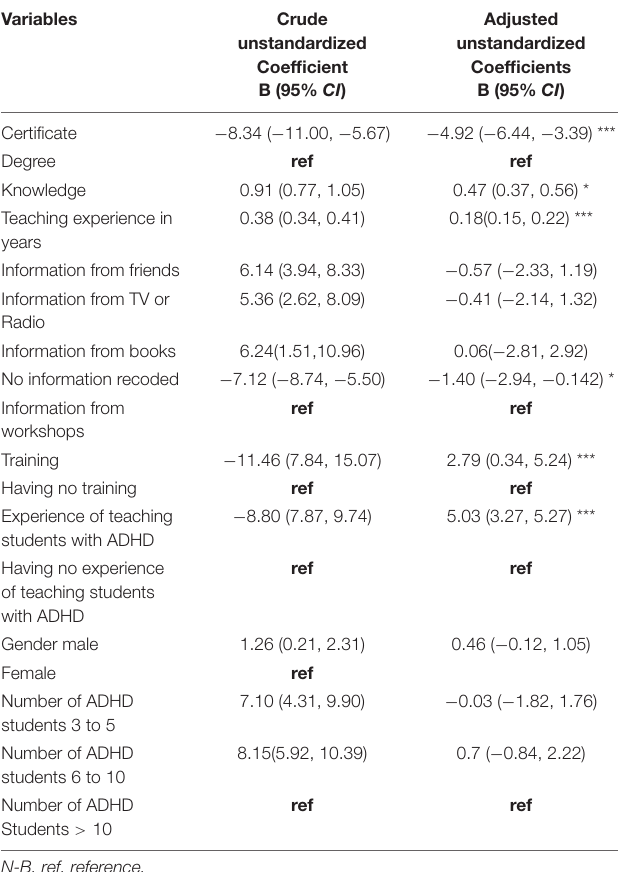
TABLE 4 | Bivariables and multivariable factors of an attitude and their corresponding explained variability among teachers of Debre Markos and Dejen towns,